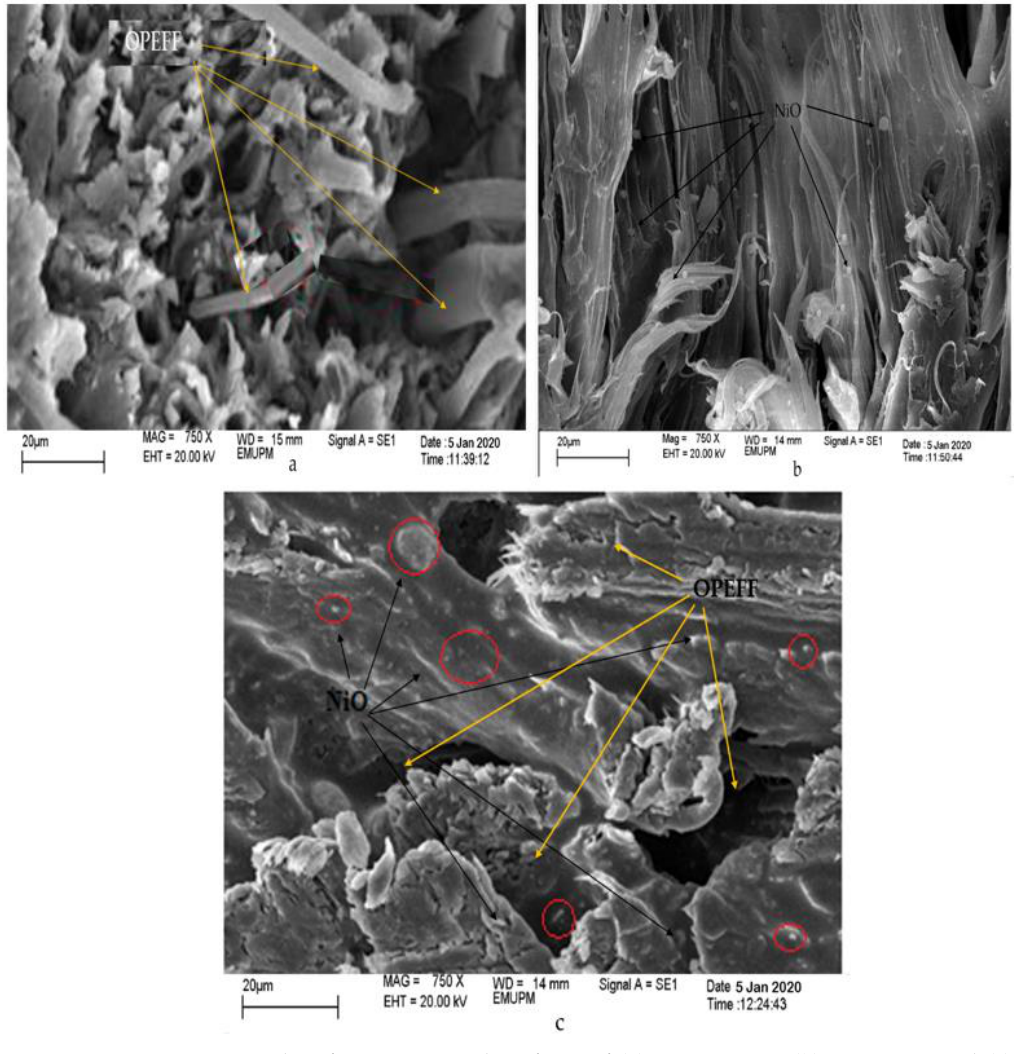
Figure 8. SEM micrographs of cross-sectional surfaces of ( a ) OPEFB / PCL, ( b ) NiO / PCL, and ( c ) NiO / OPEFB / PCL composites.